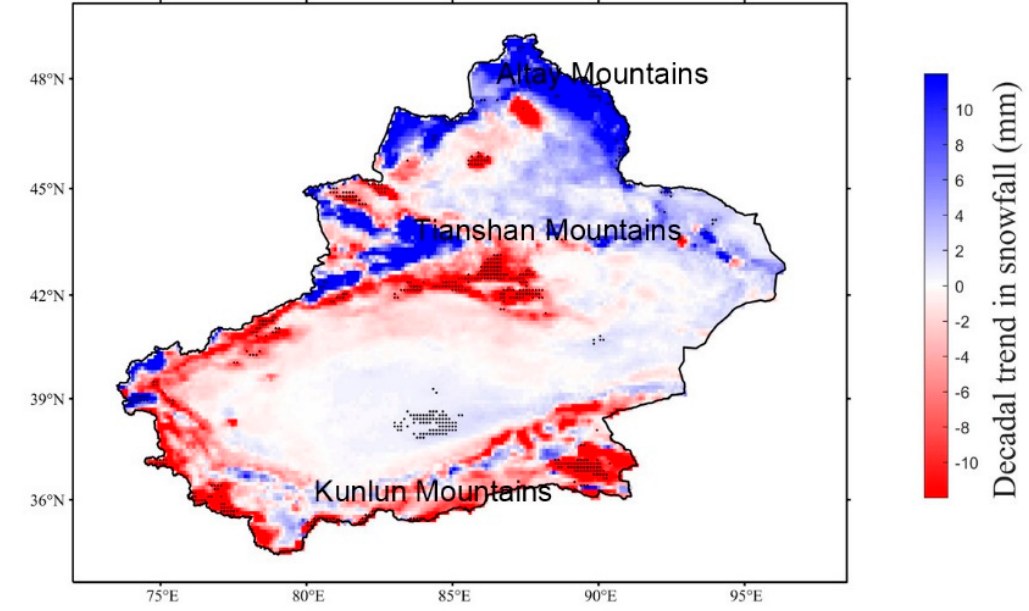
Figure 3. Spatial distribution variation of snowfall time series of WRF during the cold season from 1979 to 2015. Black dots represent significance at the 0.05 level.